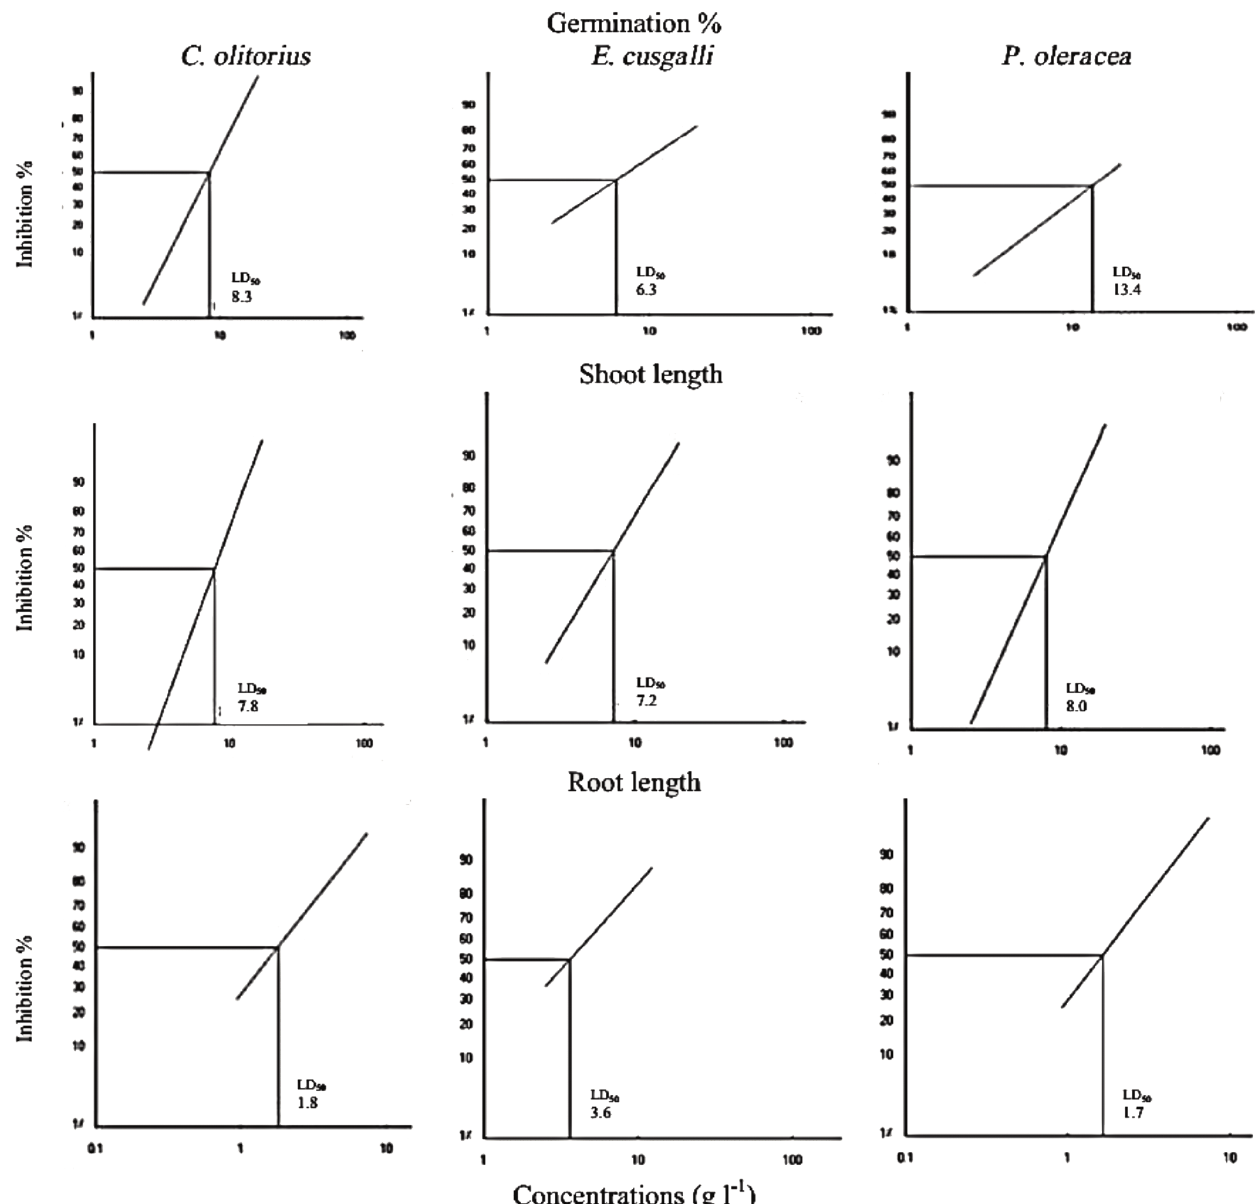
Fig. 1 - Dose-response curves showing the effect of celery extract (inhibition % and LC50) on percent germination and seedling growth of three tested